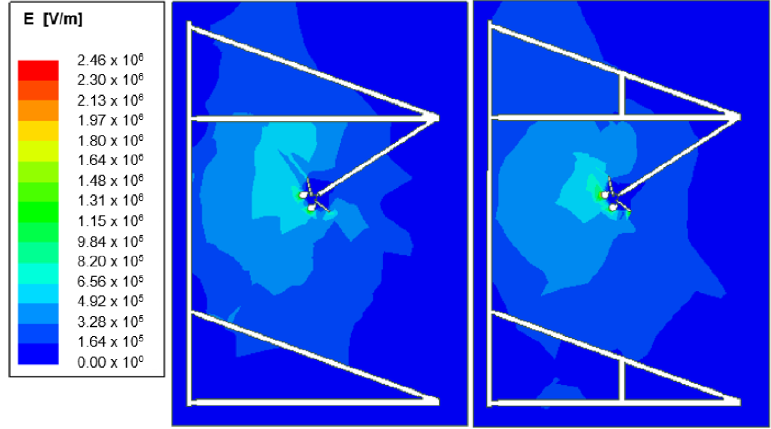
◦ inclined insulator. Energies 2020 , 13 , x FOR PEER REVIEW